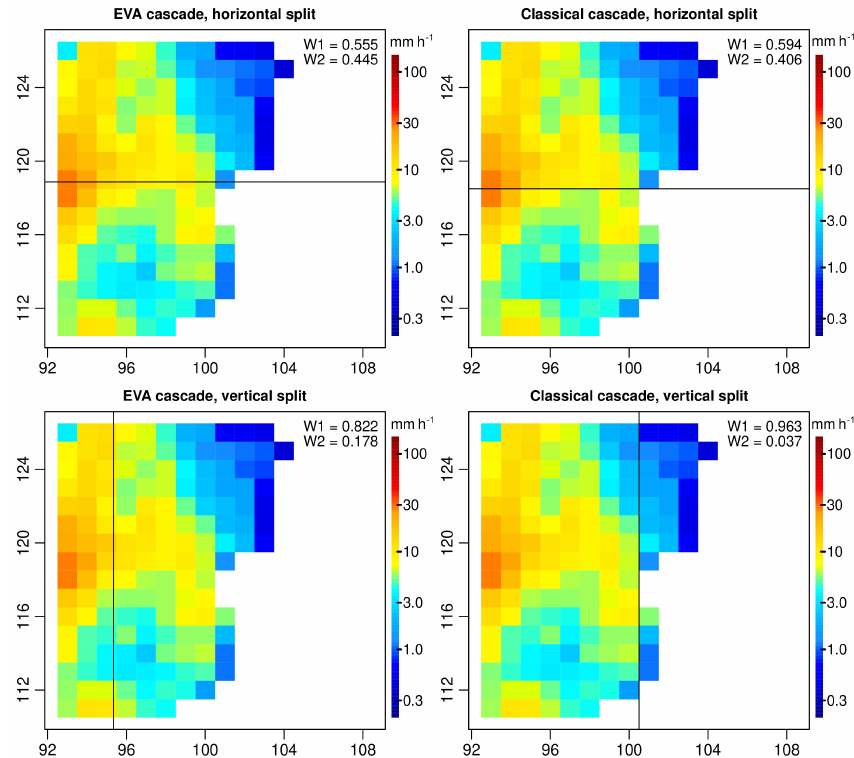
Figure 9. Example of empirical breakdown coefficients W 1 and W 2 for a 16km × 16km grid cell in event 1 (convective). The splits corre- sponding to the EVA model are shown on the left. The ones for the classical model are shown on the